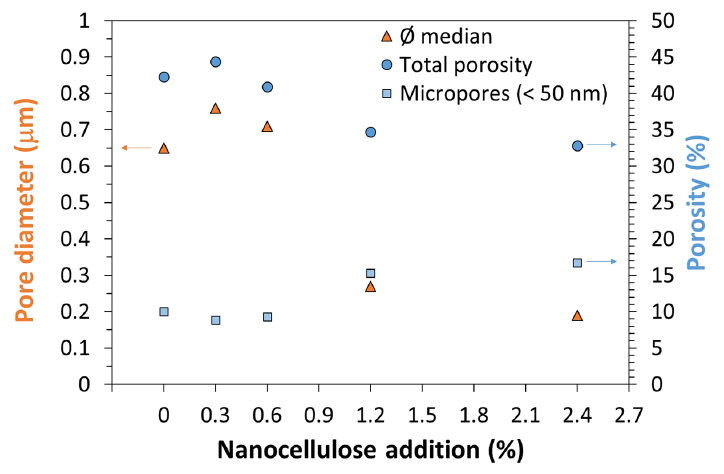
Figure 13. Summary of porosity data of mortars with different ONC content: median diameter, total porosity and micropores percentage are reported as representative of changes in pore structure.